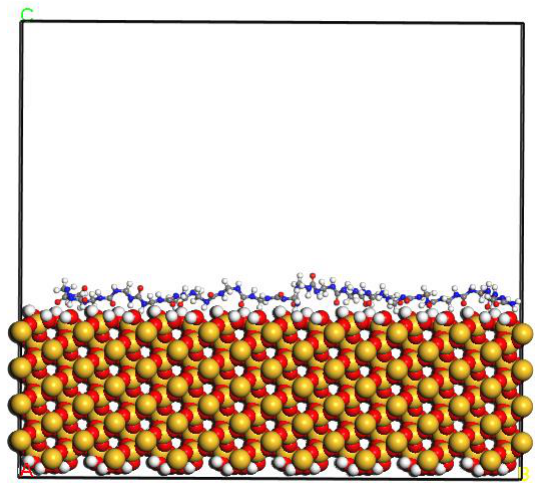
Figure 3. PUF–SiO 2 interfacial interaction model.